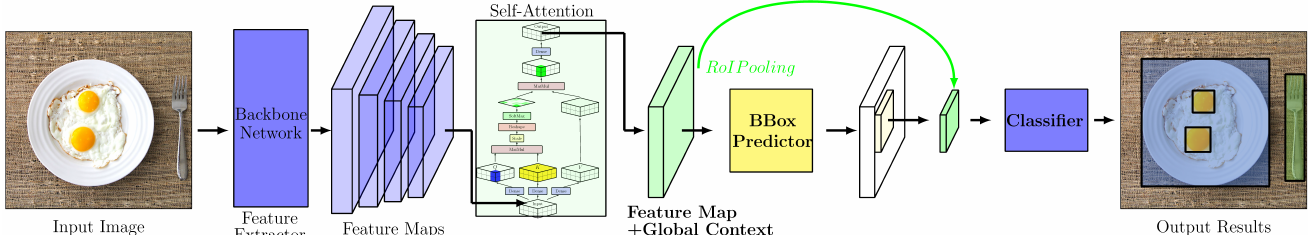
Figure 3. An overall structure for the object detection pipeline with the self-attention module. The self-attention module is applied to the top of the feature map computed by backbone networks. In the Faster R-CNN [7]; this enables the RPN to exploit both local and global contexts when generating bounding box proposals and forwarding features by “RoIPool” (RoIAlign)